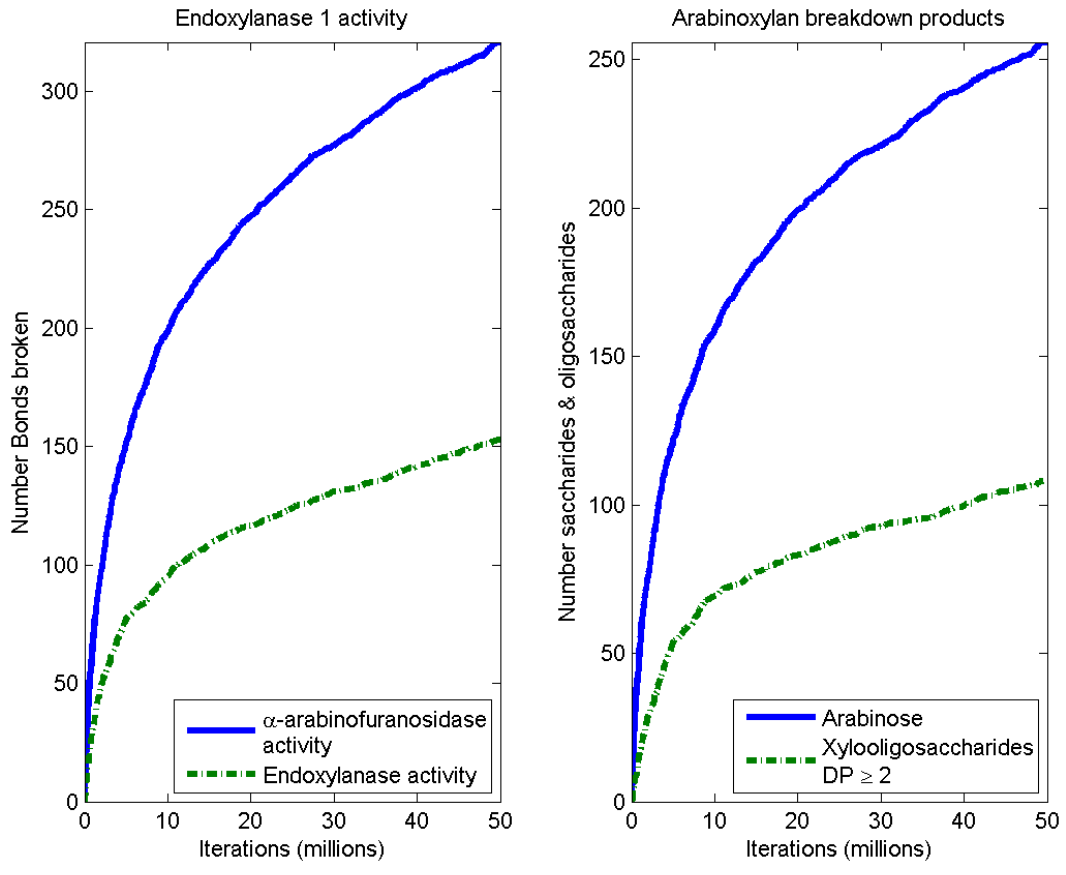
Figure 10. Simulation results showing the activity of endoxylanase 1 on arabinoxylan for the enzyme combination with equal numbers of Cel51A (endoglucanase), Cel9D and endoxylanase 1 (an endoxylanase that also has α -arabinofuranosidase activity). Arabinoses counted as breakdown products include some esterified to ferulic acid, and xylooligosaccharides include those with